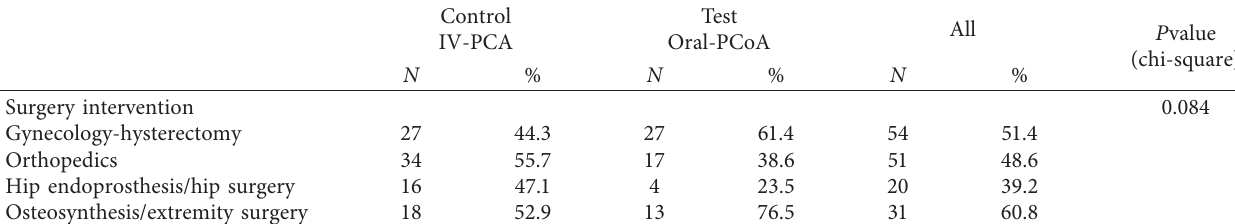
Table 1: Comparison of surgery type across study cohorts by means of a chi-square test.